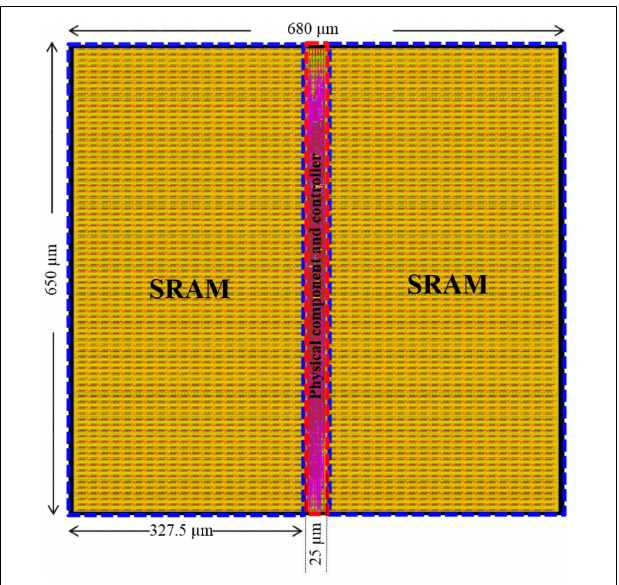
FIGURE 14 | Neural engine place and route. To achieve the maximum utilization of the hardware resources, the engine was implemented with two high density single-port SRAMs (1 M bit each, in the blue rectangles). The physical component and the controller were placed between the SRAMs such that the routing can be easily performed. The utilization of the silicon area is 98.7 and 70.5% with and without SRAMs,